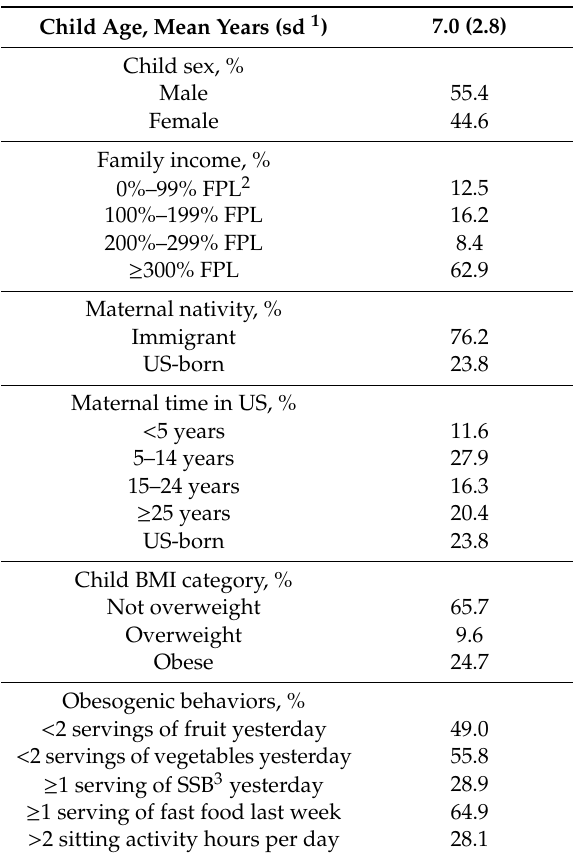
Table 1. Weighted characteristics of Asian American children ages 2 to 11 years old and their mothers (n = 609): California Health Interview Survey (CHIS)